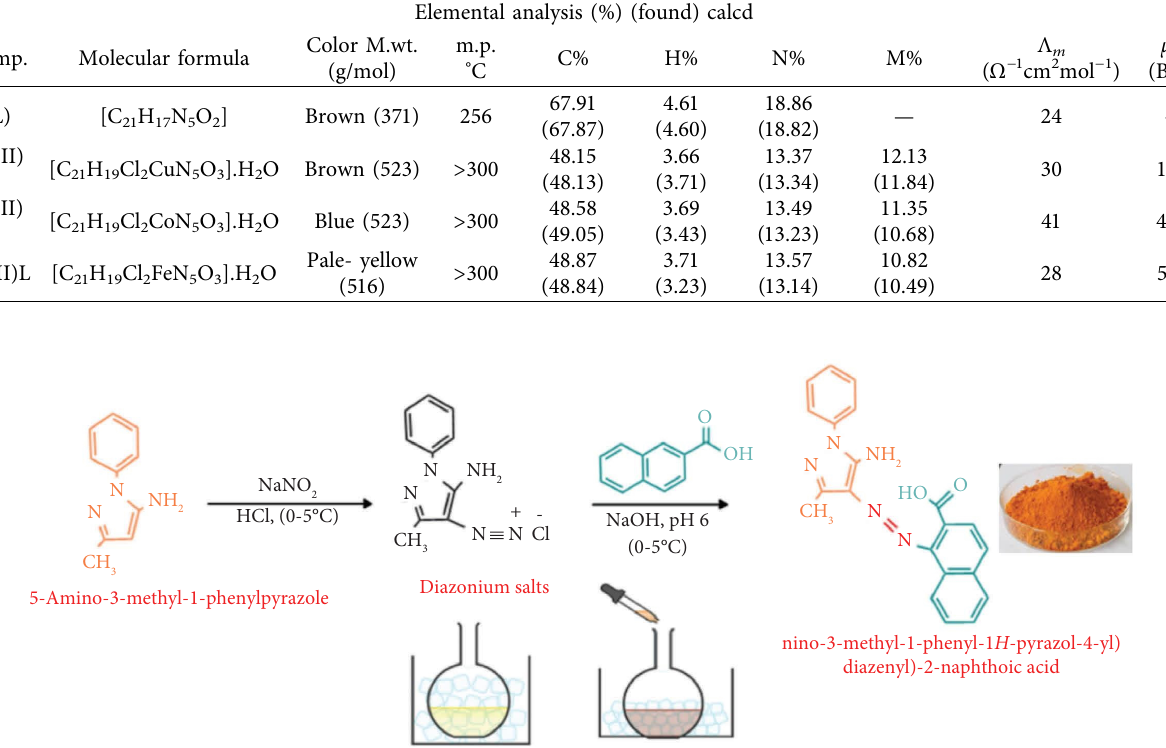
Scheme 1: Synthesis of heterocyclic azo dye ligand